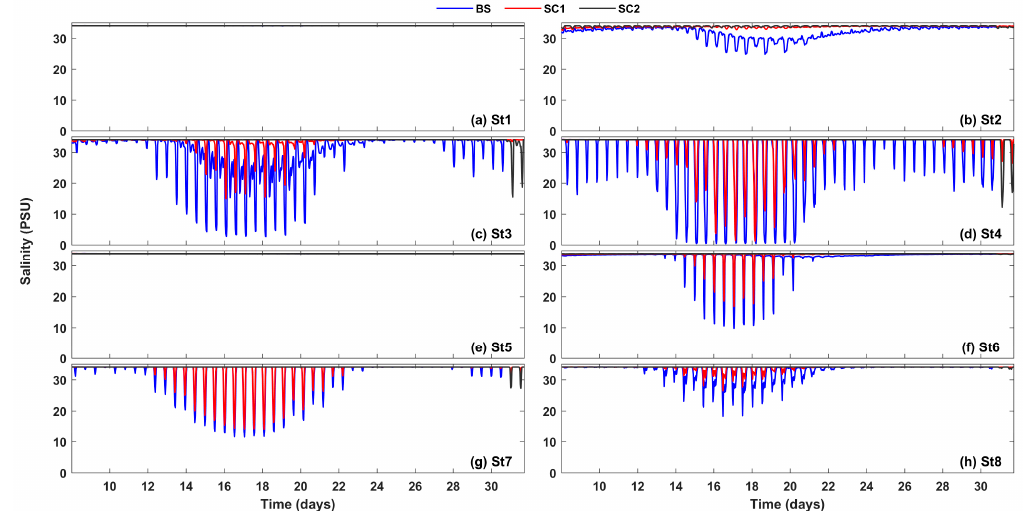
Figure 3. Time series of salinity for the scenarios BS, SC1 and SC2, for September 2000, and the lagoon stations: ( a ) St1, ( b ) St2, ( c ) St3, ( d ) St4, ( e ) St5, ( f ) St6, ( g ) St7 and ( h ) St8.